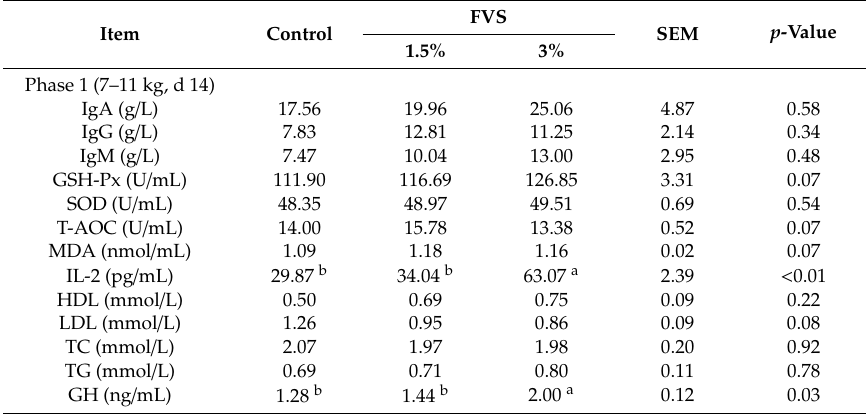
Table 10. E ff ects of dietary Flammulina velutipes stem waste (FVS) supplementation on serum profile of piglets on day 14, day 35 and day 56